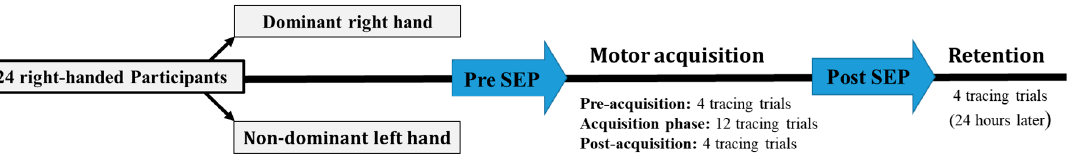
Figure 2. Experimental protocol.